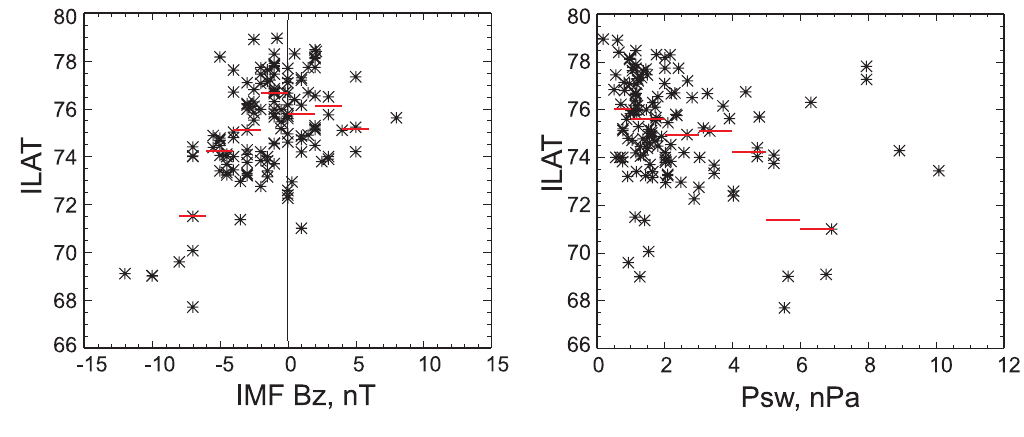
Fig. 6. Correlation of the invariant latitude ILAT of the electron boundary of the LLBL/cusp and external parameters: IMF B Z -component (left panel) and solar wind dynamic pressure (right panel). The horizontal red bars in the figures show the median values of the ILAT in each bin.